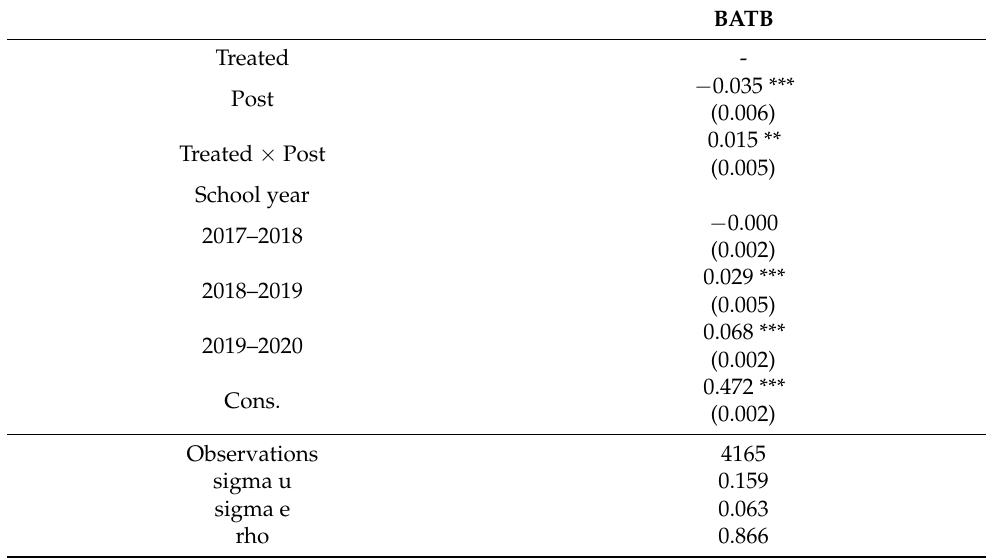
Table 3. Fixed Effects